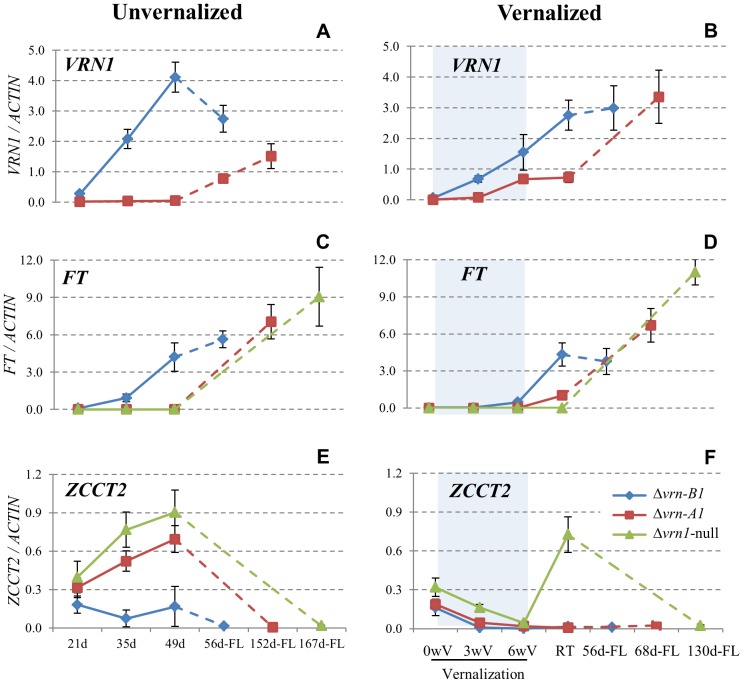
qRT–PCR transcriptional profiles of VRN1, FT, and ZCCT2 ( = VRN2) in mutant set 1 (premature stop codon).A–B) VRN1, C–D) FT, E–F) ZCCT2. Left panels A, C and E) unvernalized plants. Right panels B, D, and F) vernalized plants. Δvrn-A1: mutation in VRN-A1 (winter, functional vernalization responsive VRN-B1 allele), Δvrn-B1: mutation in VRN-B1 (spring, functional vernalization insensitive VRN-A1 allele), Δvrn1-null: truncated VRN1 proteins. Blue shaded areas indicate vernalization at 4°C under long days. 0 wV: 3 weeks-old plants grown under 22°C/17°C (day/night) conditions before vernalization, 3 wV: 3 weeks of vernalization, 6 wV: 6 weeks of vernalization, RT: two weeks after returning the vernalized plants to pre-vernalization conditions. A final sample was obtained from flag leaves at heading times (FL, dotted lines), which are indicated in days from sowing to heading. The X axis scale is not proportional to time and the Y scale is in fold-ACTIN values. Error bars are SE of the means from 8 biological replications.